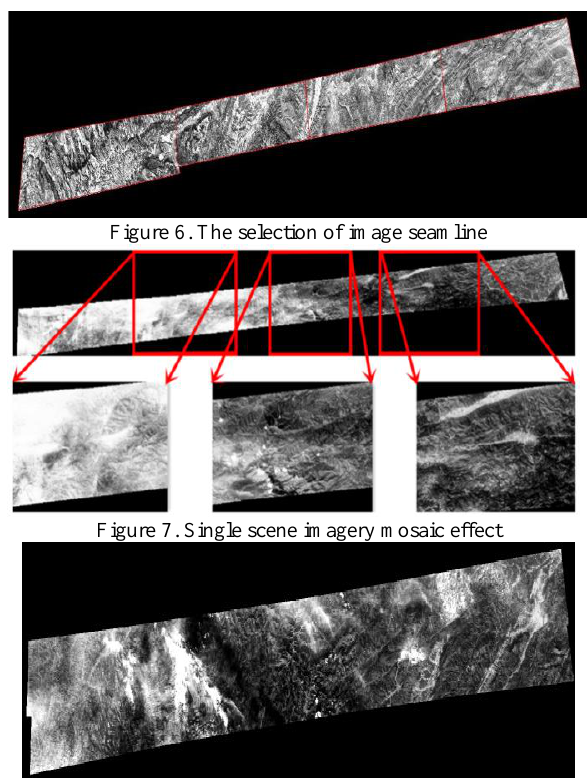
Figure 8. Double scene imagery mosaic effect